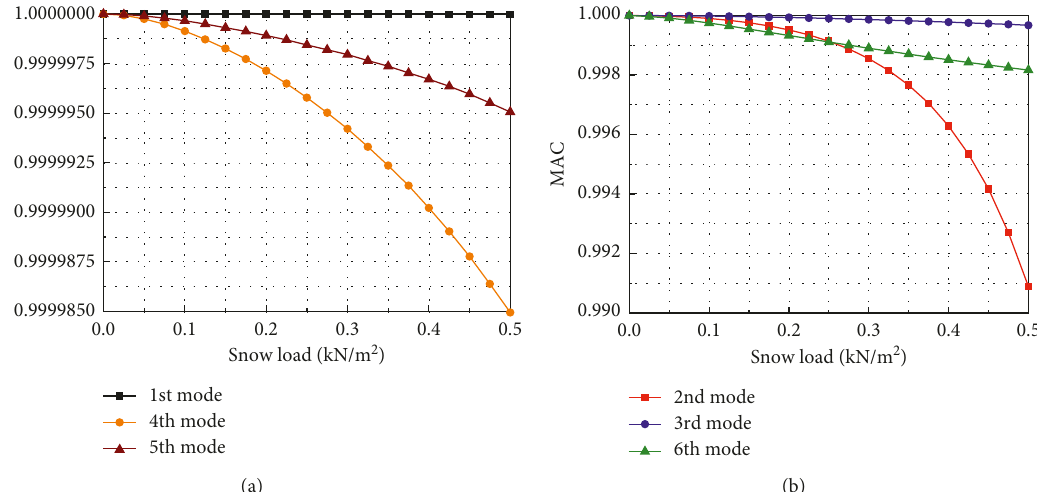
Figure 31: MAC values of the mode shapes on longitudinal direction under nonuniformly distributed snow load: (a) the 1st, 4th, and 5th modes and (b) the 2nd, 3rd, and 6th modes.